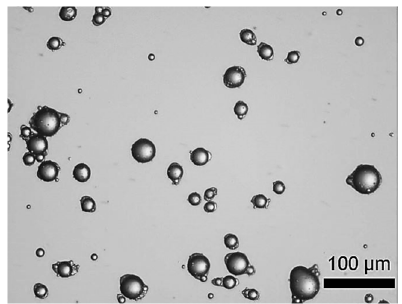
Figure 1. LM-entrapping microcapsules with an elongated eye-like shape by complex coacervation.